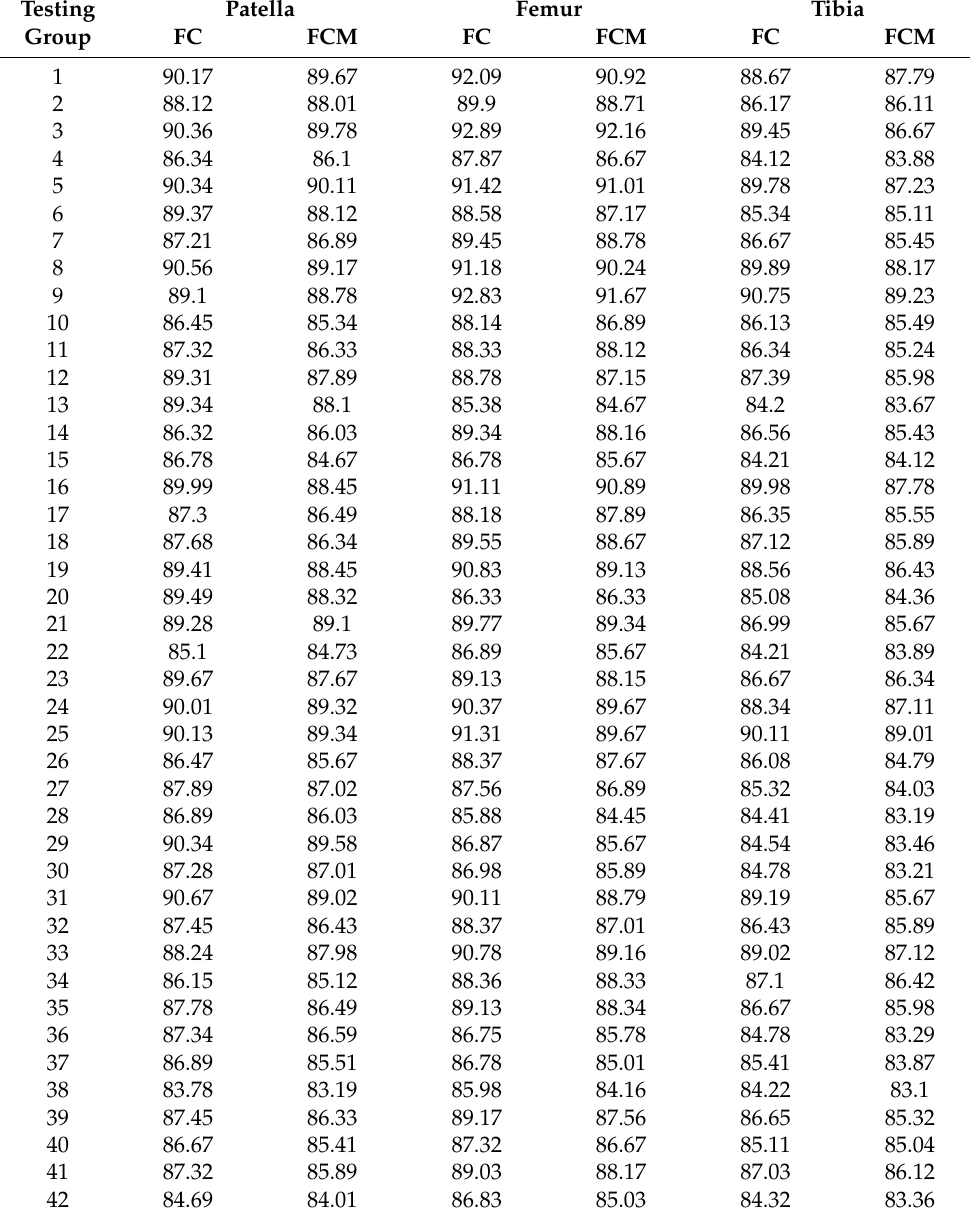
Table 6. Dice index values for the analyzed MRI series, for the FC and FCM